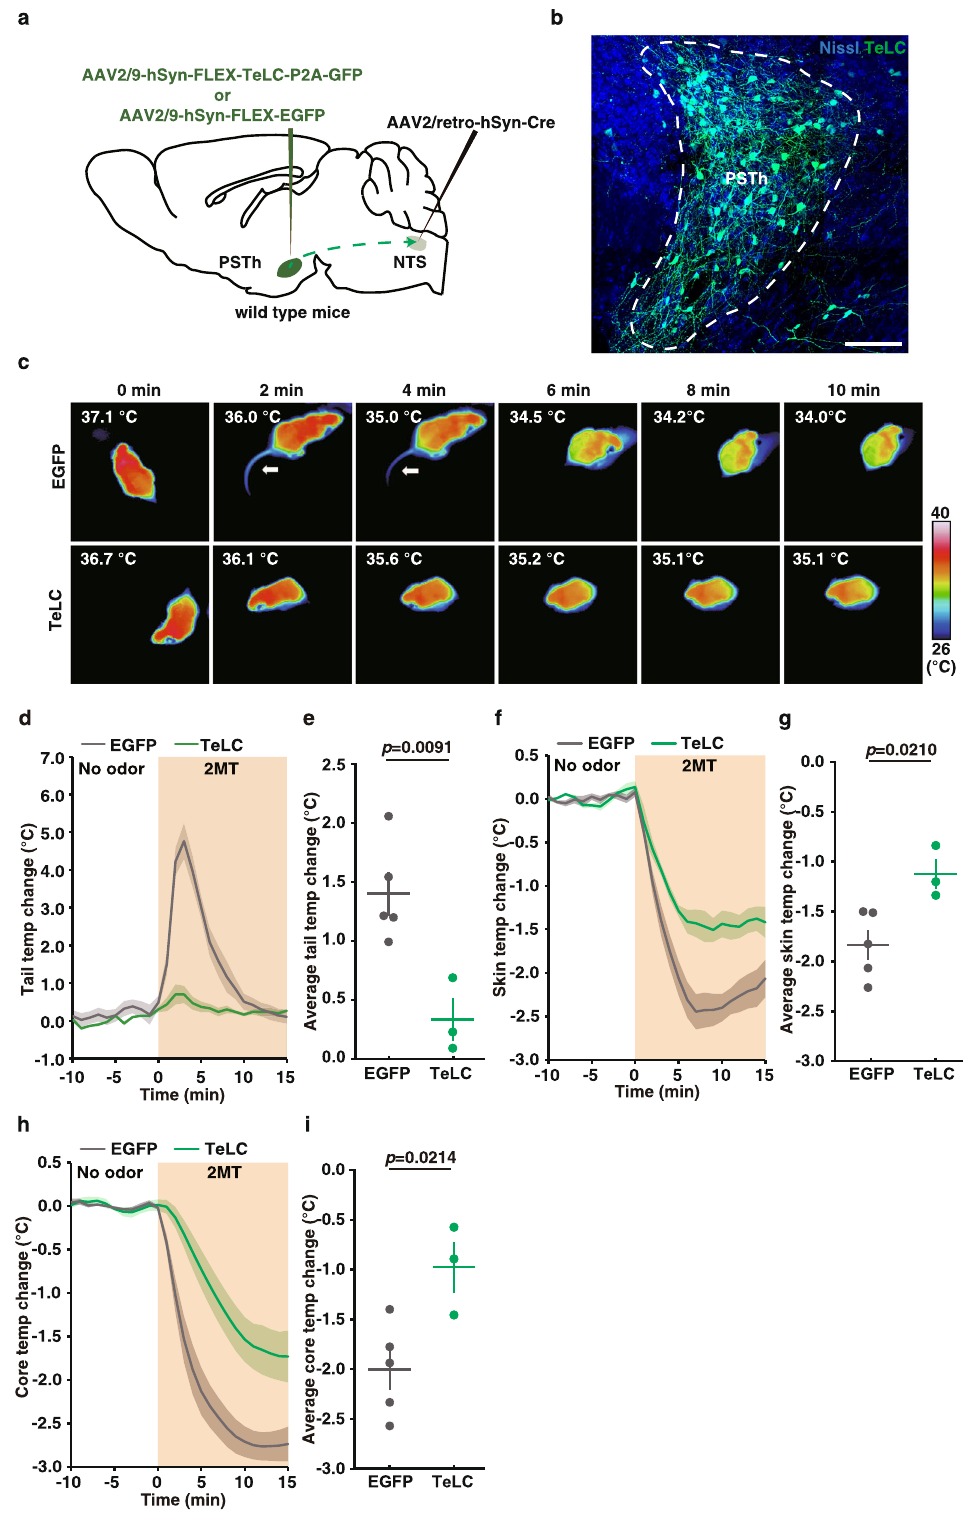
Fig. 3 TeLC-mediated inactivation of NTS-projecting PSTh neurons diminishes 2MT-evoked hypothermia and abrogates tail temperature increase. a Schematic of TeLC-mediated inactivation of PSTh neurons in wild-type mice. b Representative image showing TeLC-GFP-labeled NTS-projecting PSTh neurons ( n = 5). c Time-lapsed thermal images of wild-type mice without (EGFP, up) or with (TeLC, bottom) inactivation of NTS-projecting PSTh neurons during 2MT treatment. Tail ( d ), skin ( f ), and core ( h ) temperature curves of EYFP-expressing ( n = 5) and TeLC-expressing ( n = 3) mice before and during 2MT treatment. Average tail ( e ), skin ( g ), and core ( i ) temperature changes of EGFP-expressing ( n = 5) and TeLC-expressing ( n = 3) mice during 2MT treatment. Two TeLC-expressing mice were not included in the analysis because of low virus transduction rate (Supplementary Fig. 3). d – i Data are mean ± SEM; two-side Student ’ s t test. Scale bar, 100 µ